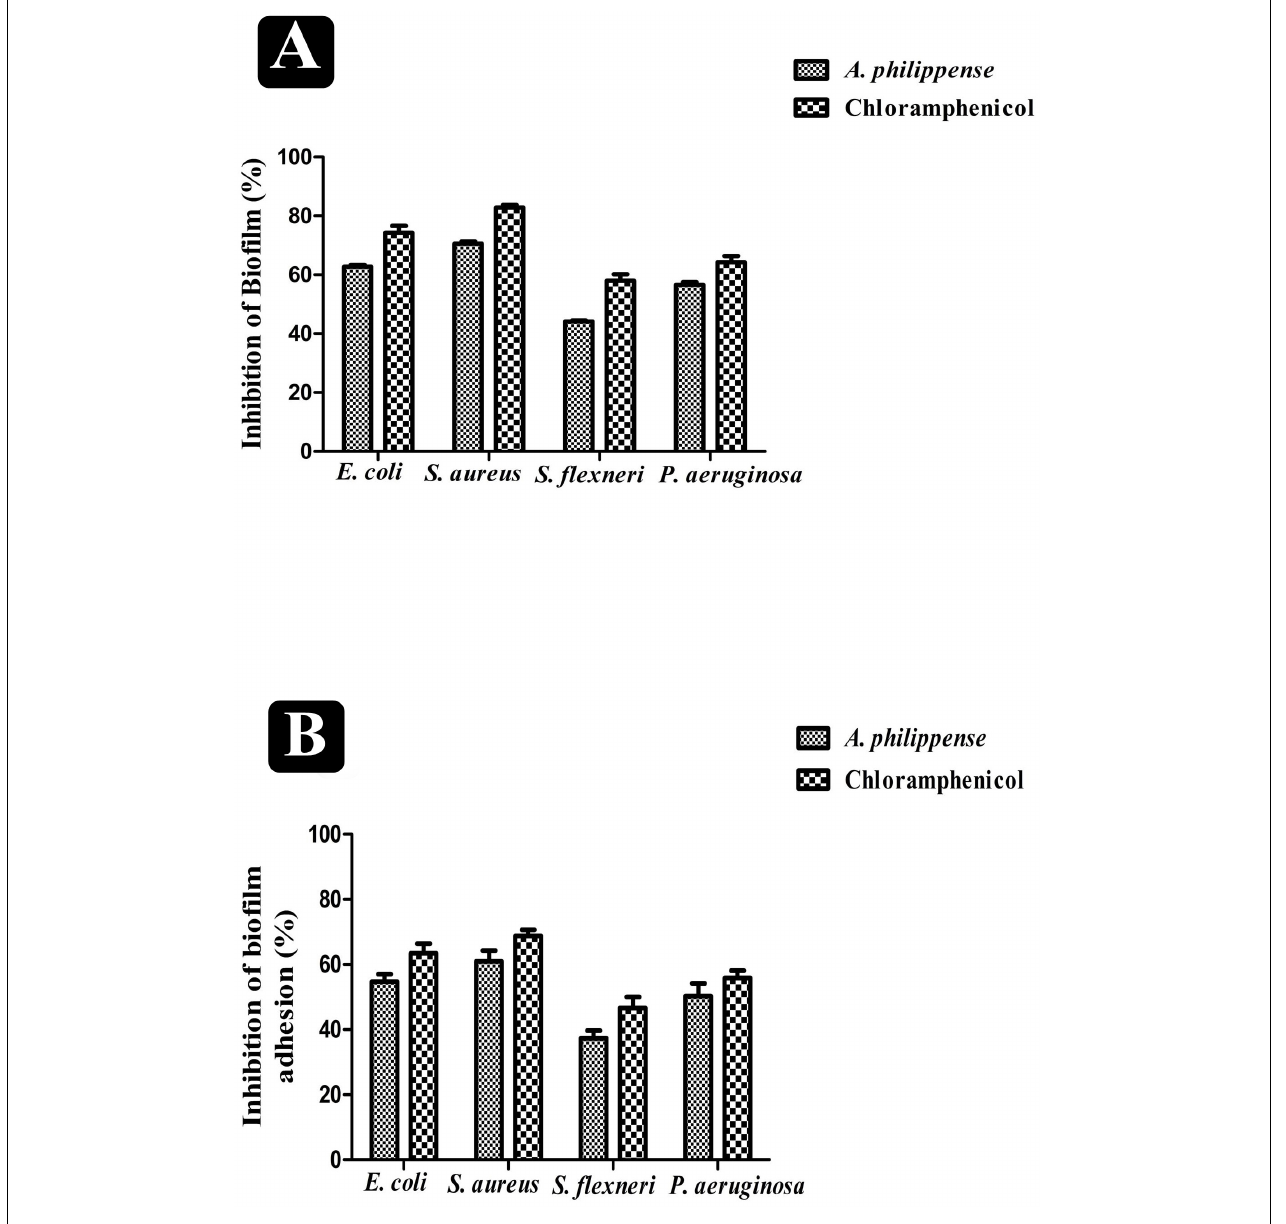
FIGURE 4 | Antibiofilm potential of A. philippense . (A) Effect of A. philippense crude extract on established biofilms of E. coli , S. aureus , P. aeruginosa, and S. flexneri ; and (B) effect of A. philippense crude extract on adherence ability of E. coli , S. aureus , P. aeruginosa , and S. flexneri . Chloramphenicol was used as positive control. All experiments were carried out in triplicate, and data represent the mean ±